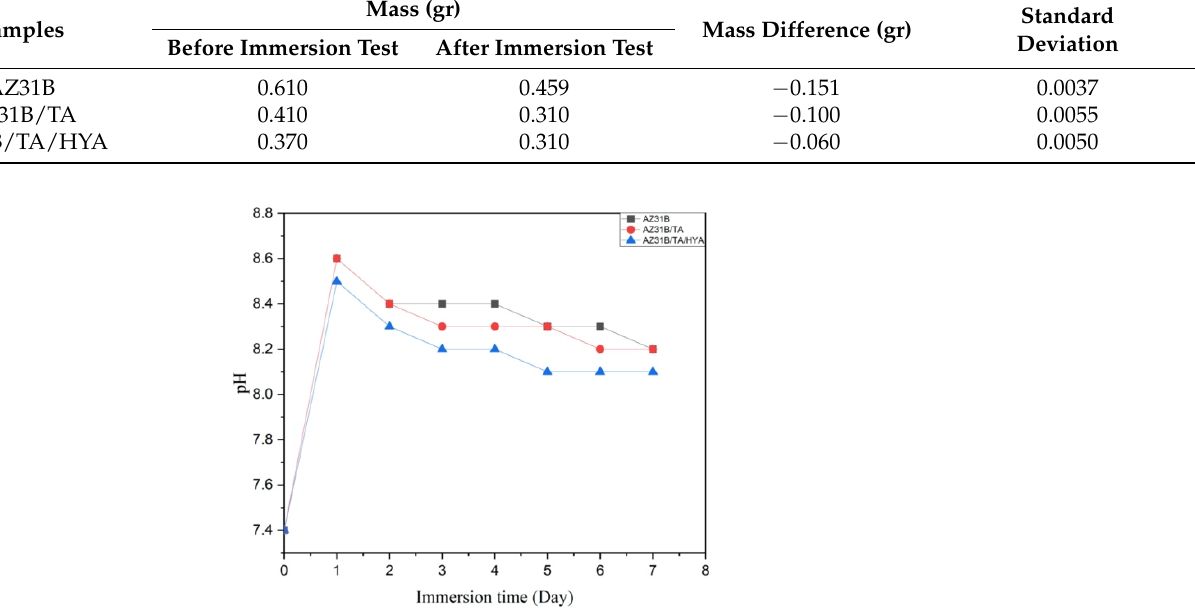
Figure 8. XRD results of samples AZ31B, AZ31B/TA, and AZ31B/TA/HYA after seven days of SBF immersion test.